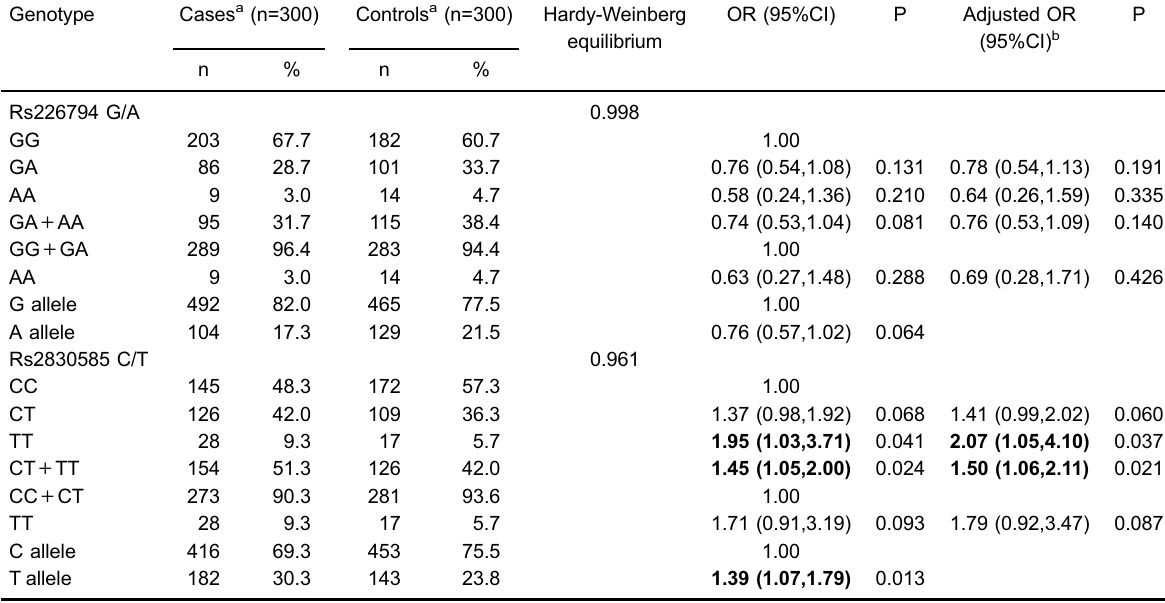
Table 3. Logistic regression analysis of associations between ADAMTS5 gene polymorphisms and risk of osteoarthritis. Genotype